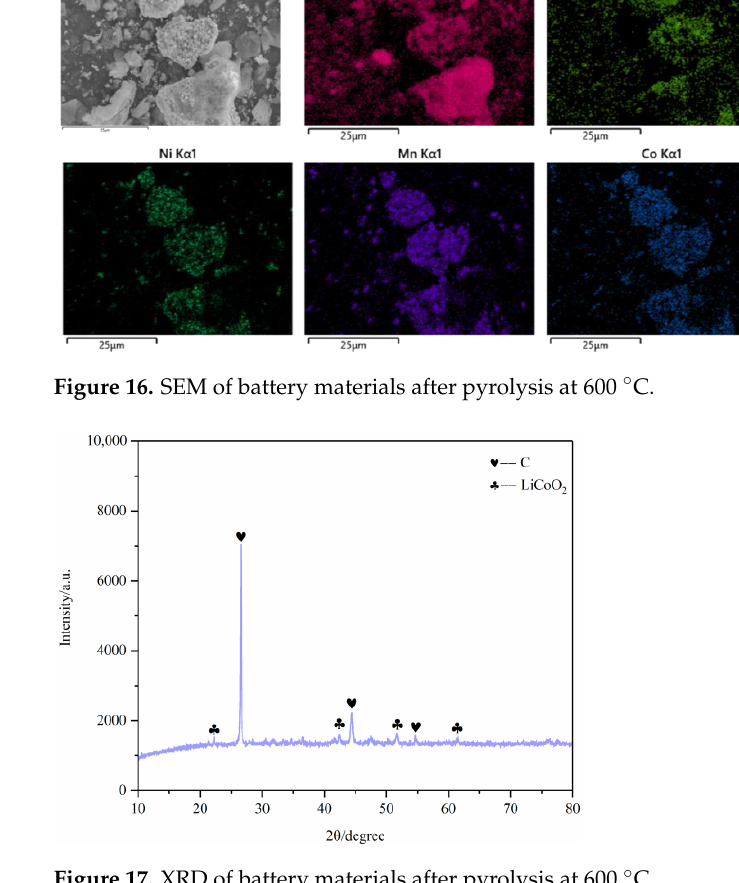
Figure 17. XRD of battery materials after pyrolysis at 600 °C.